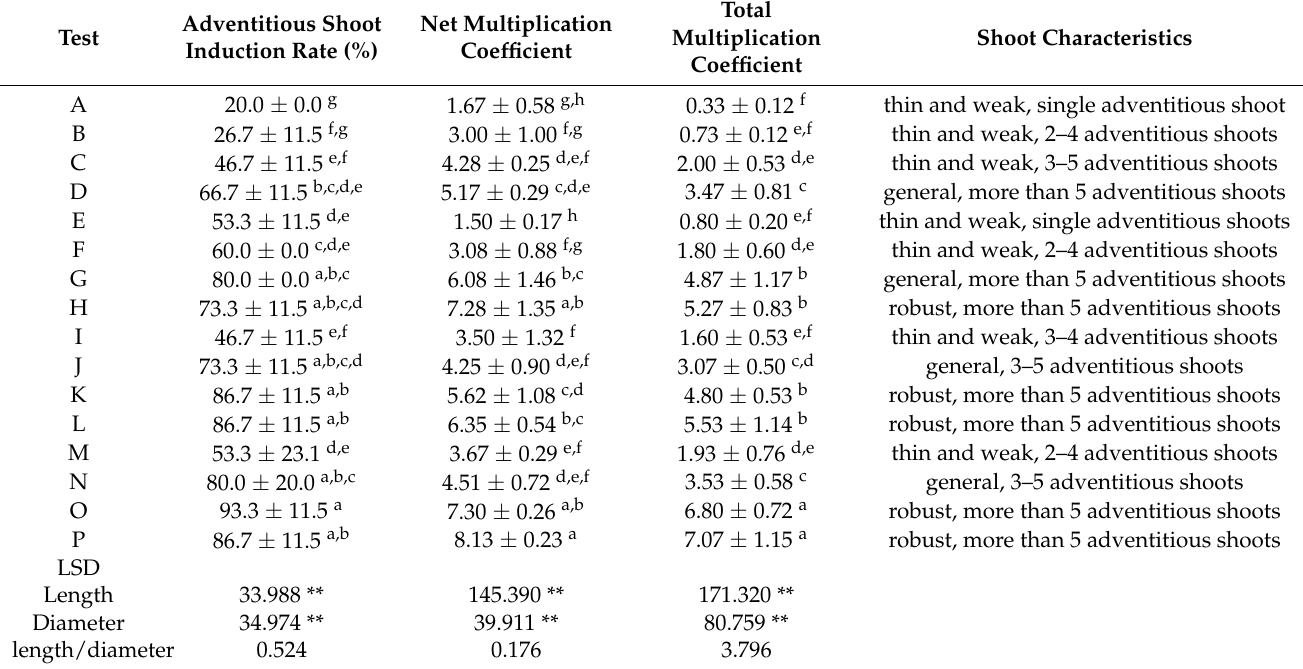
Table 2. Effects of different root cutting lengths and diameters on root propagation’s adventitious shoot induction rate and the multiplication coefficient of Broussonetia papyrifera